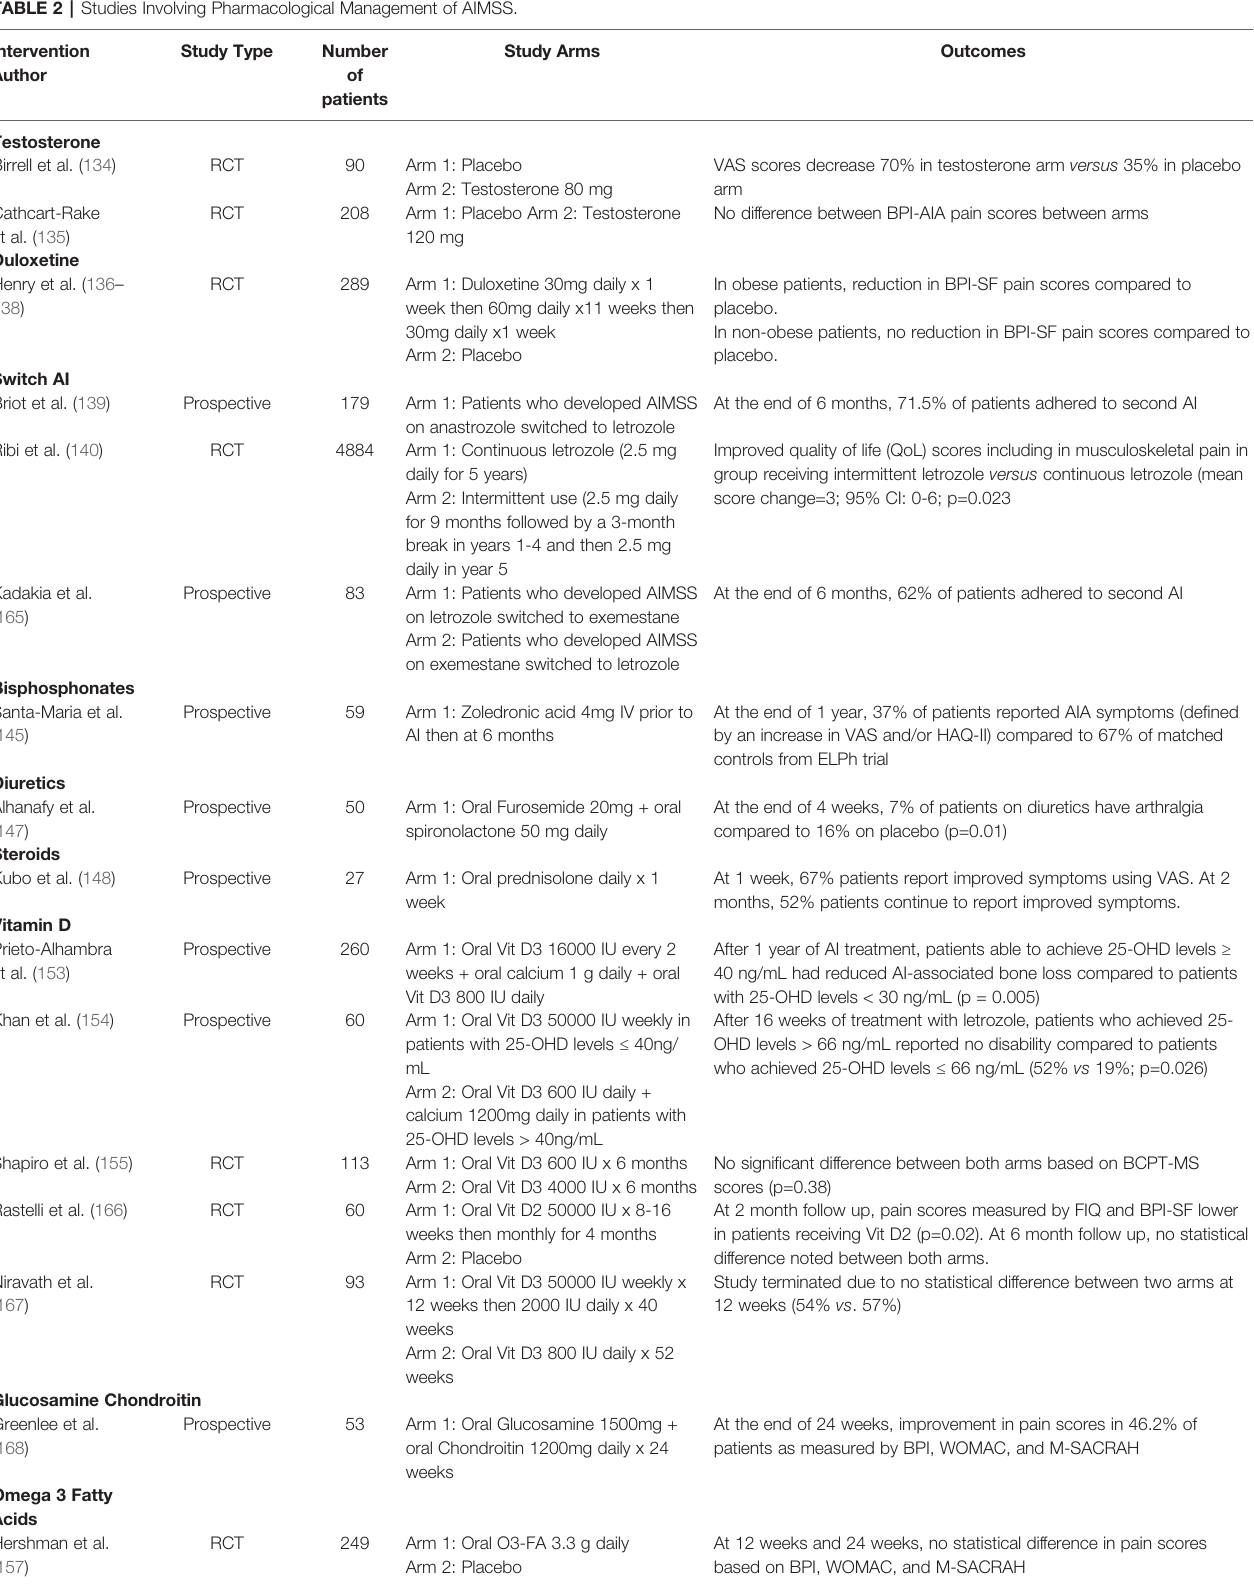
TABLE 2 | Studies Involving Pharmacological Management of